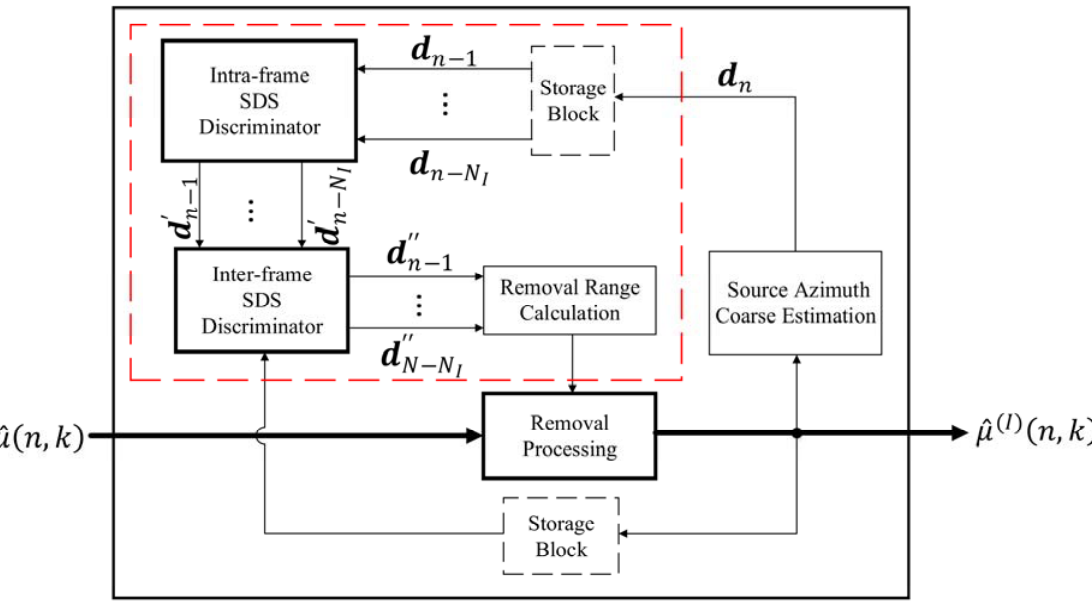
Figure 5. The block diagram of the components removal with joint intra-frame and inter-frame SDS discrimination.